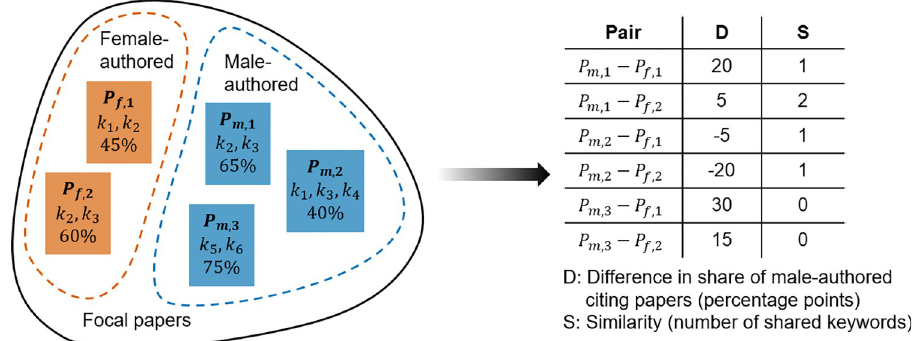
Fig 3. Generating pairs of focal papers. On the left, five focal papers are illustrated, together with their keywords (k i ) and the share of male-authored citing papers (in %). The table on the right shows all pairs of focal papers such that one paper of a pair is female-authored and the other paper is male-authored. Column D shows the difference in the share of male-authored citing papers for a pair, which is used as an indicator for the degree of gender homophily. Column S shows the number of shared keywords, which is used as an indicator for the similarity between two papers.